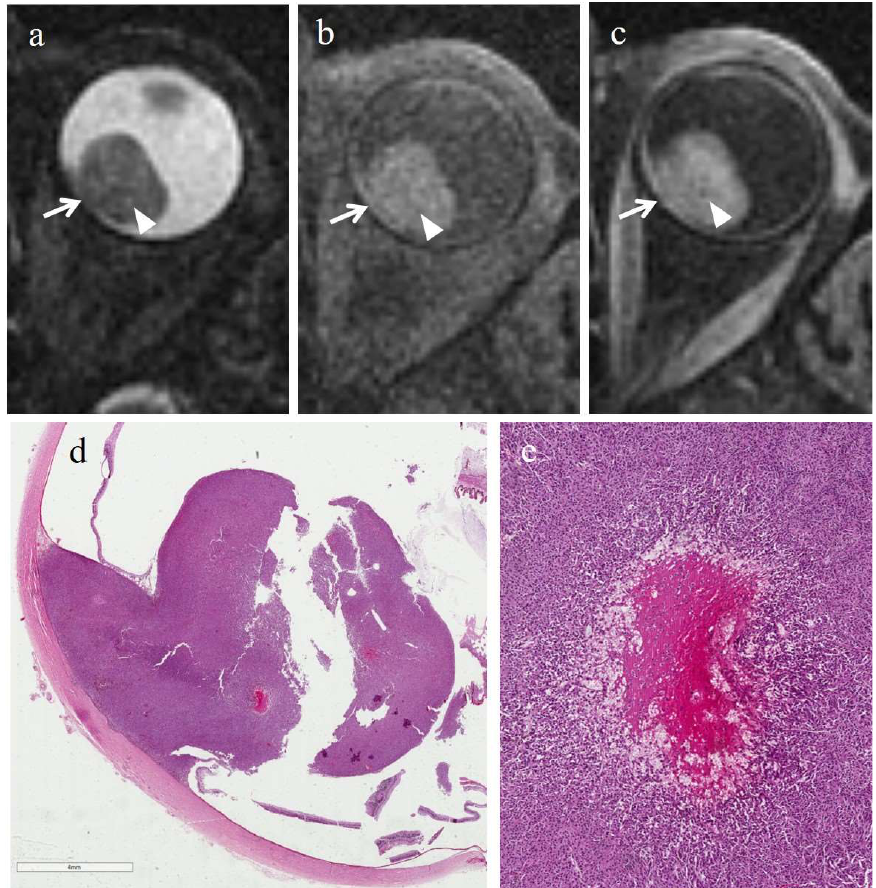
Figure 6. Hemorrhagic/coagulative-type necrosis in nonirradiated group (primary enucleation). A 79-year-old female patient with a poorly pigmented choroidal melanoma of the left eye. Axial ( a ) T2-weighted turbo spin-echo STIR, ( b ) fat-suppressed T1-weighted and ( c ) contrast-enhanced fat-suppressed T1-weighted images show a large intraocular collar-button mass along the posterior aspect of the globe (white arrows), demonstrating intermediate signal intensity on T2-weighted and plain T1-weighted images, and enhancement after contrast agent administration on T1-weighted image. Some small rounded areas, relatively hyperintense on T2-weighted image (white arrowhead in ( a )), without enhancement on contrast-enhanced fat-suppressed T1-weighted mage (white arrowhead in ( c )) are perceivable inside the lesion and hardly detectable on unenhanced T1-weighted image (white arrowhead in ( b )). ( d ) Histologically, low magnification (H&E, original magnification 25 × ) illustrates a poorly pigmented, protruding melanoma mass of the posterior segment of the eye, that induces retinal detachment. ( e ) Histological detail (H&E, original magnification 150 × ) of a focus of intratumoral hemorrhagic/coagulative-type necrosis, characterized by fibrin deposition and hemorrhagic infarction, and rimed by extravasated